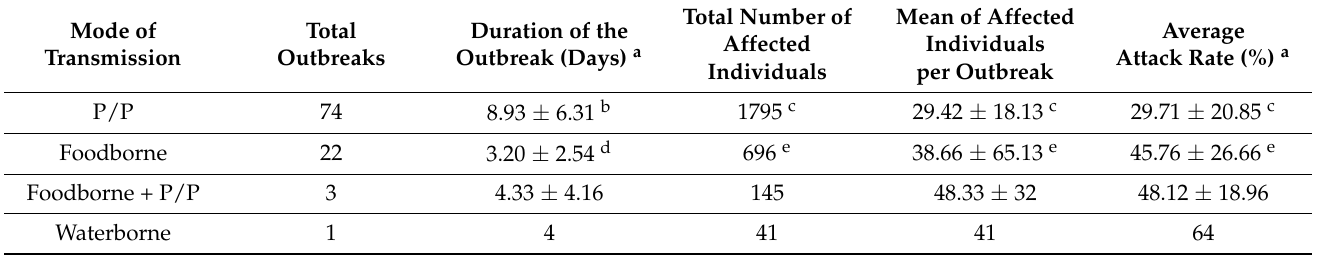
Table 1. Main epidemiological features of outbreaks included in the study, by mode of transmission.